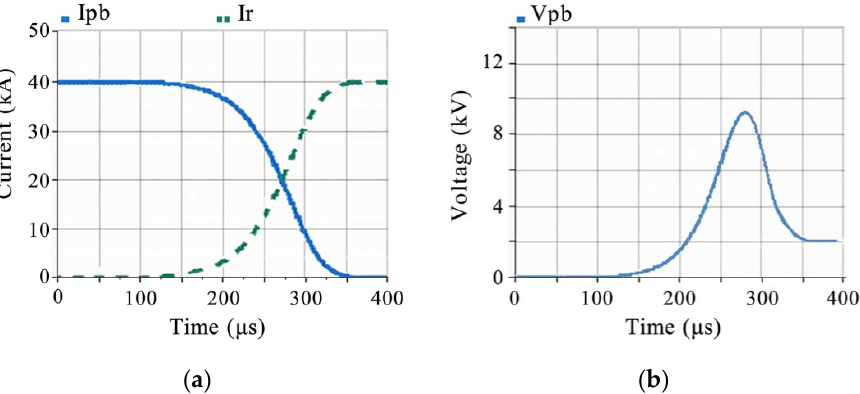
Figure 6. The circuit model of the commutation test in PSCAD.